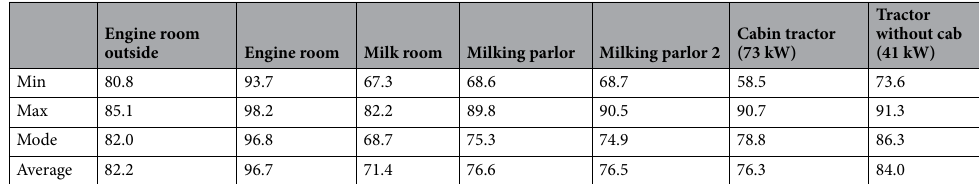
Table 5. Level of noise in decibel (dB) recorded in different livestock and agricultural working situations/ places with the sound level meter. *In all scenarios the machines were in